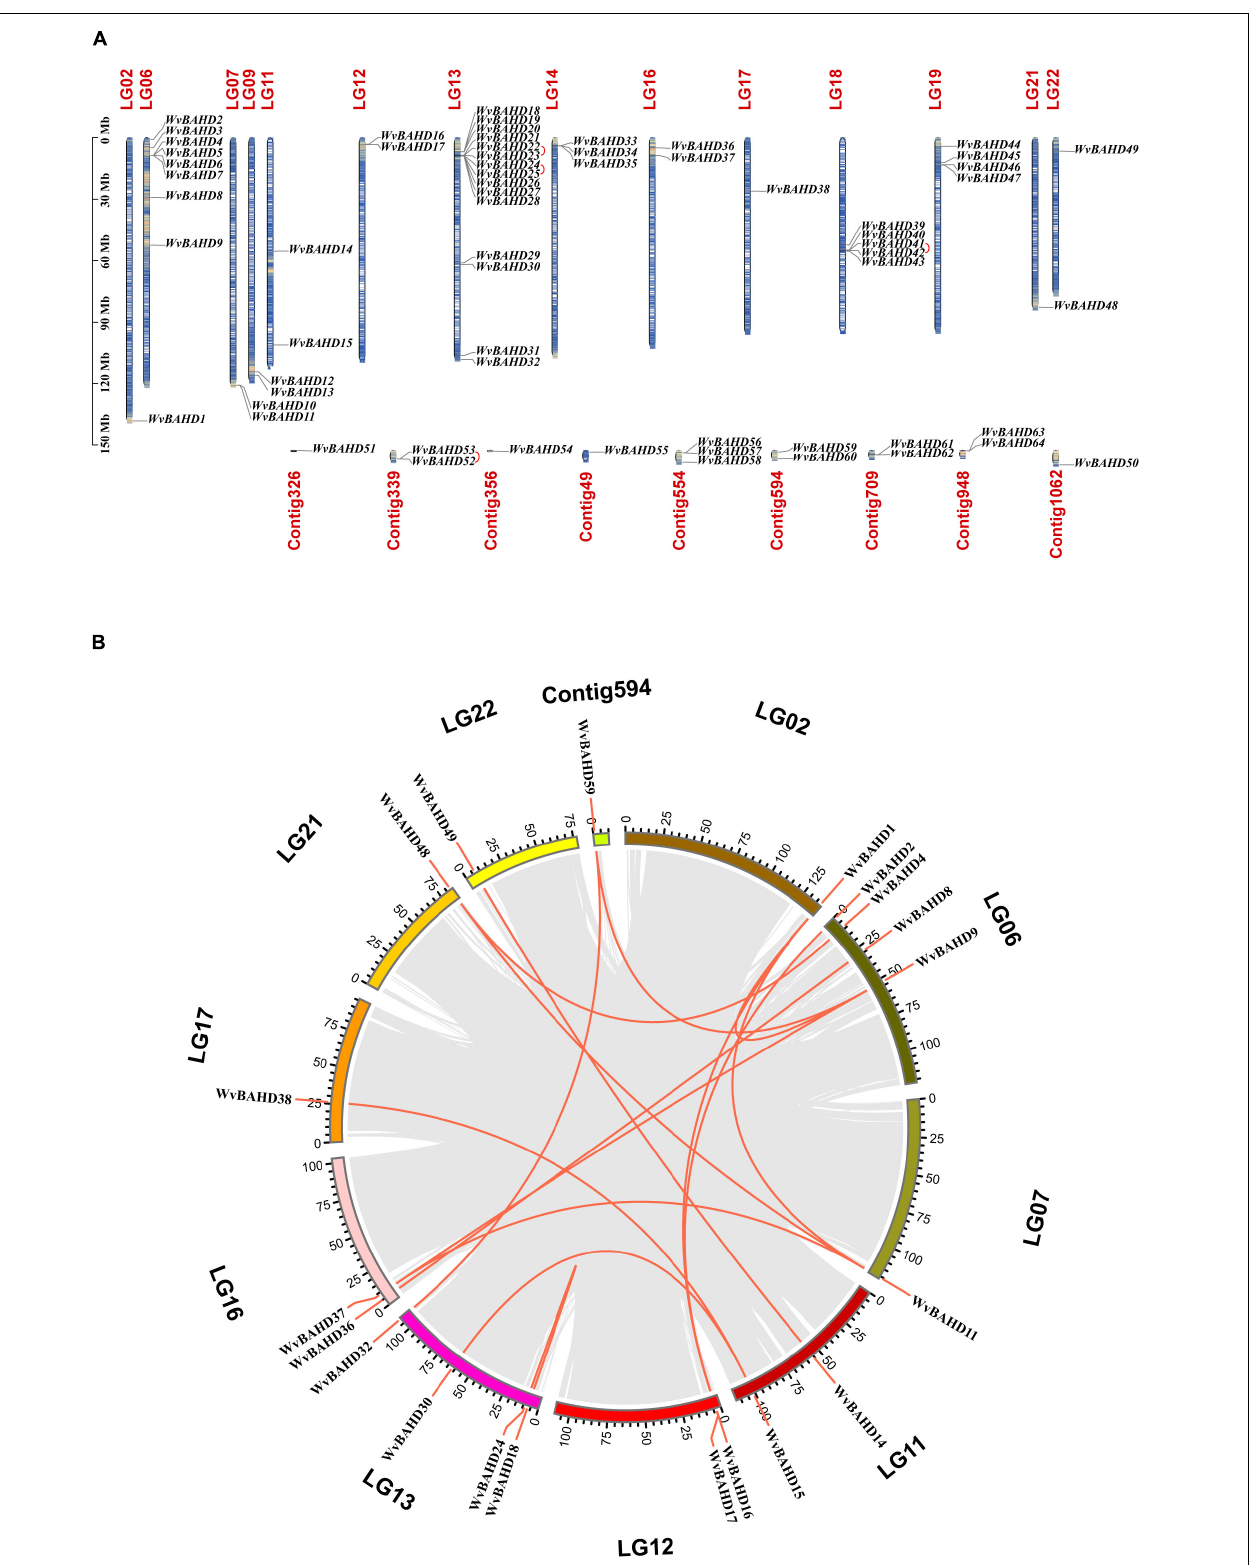
FIGURE 2 | Gene location and collinearity analysis of the WvBAHD gene family. (A) Chromosome location and distribution analysis of WvBAHD genes. Tandem duplicated genes are linked by a red line. (B) Chromosomal duplication analysis of WvBAHD genes in circos graph. Red lines represent the syntenic gene pairs.